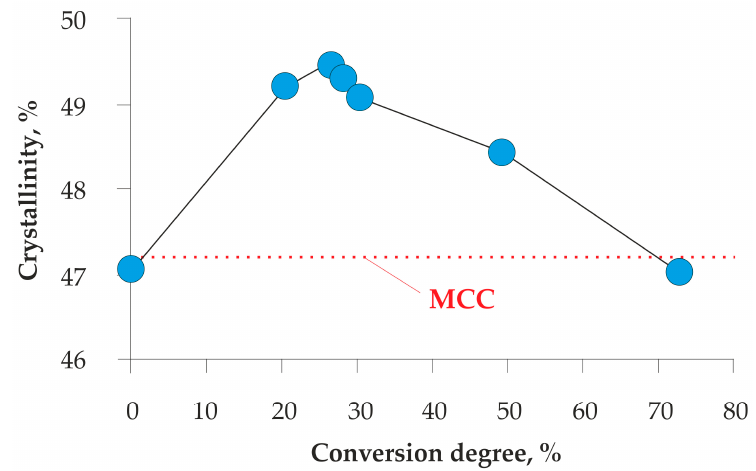
Figure 4. Changes in crystallinity of biomodified kraft pulp during enzymatic hydrolysis by P. verruculosum cellulases.